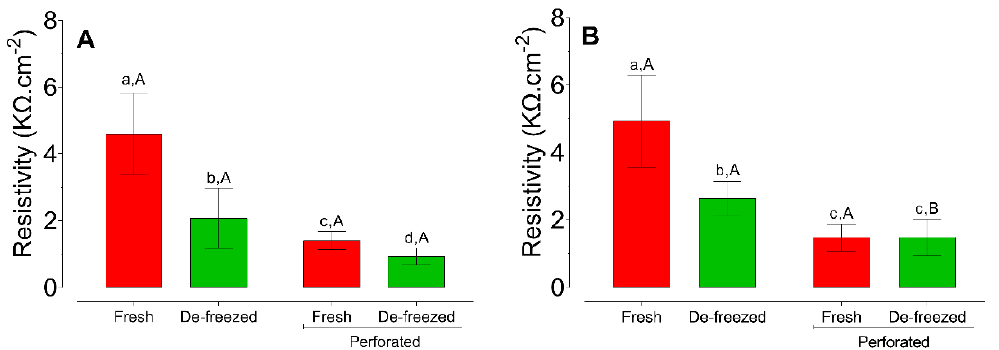
Figure 4. Mean ( ± SD) electrical resistivity values (k Ω /cm 2 ) for the esophageal ( A ) and buccal ( B ) mucosas before and after freezing. Capital letters above the bars indicate statistically significant differences between the mucosas, considering the same storage conditions. Lowercase letters above the bars indicate statistically significant differences between the storage conditions, considering the same